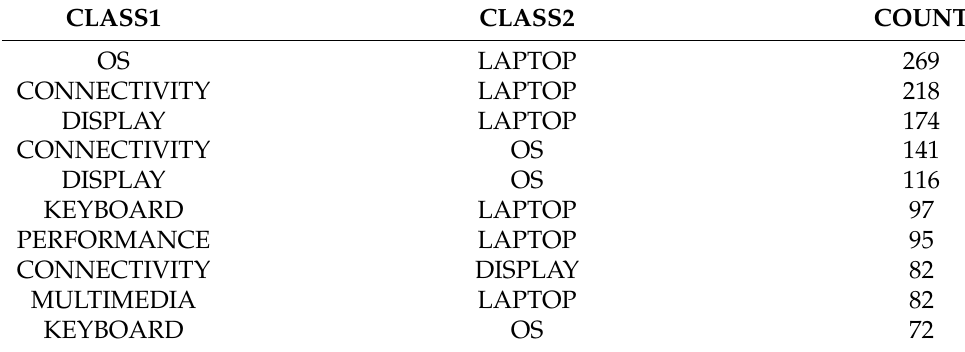
Table 4. Top 10 negative co-mentioned aspect